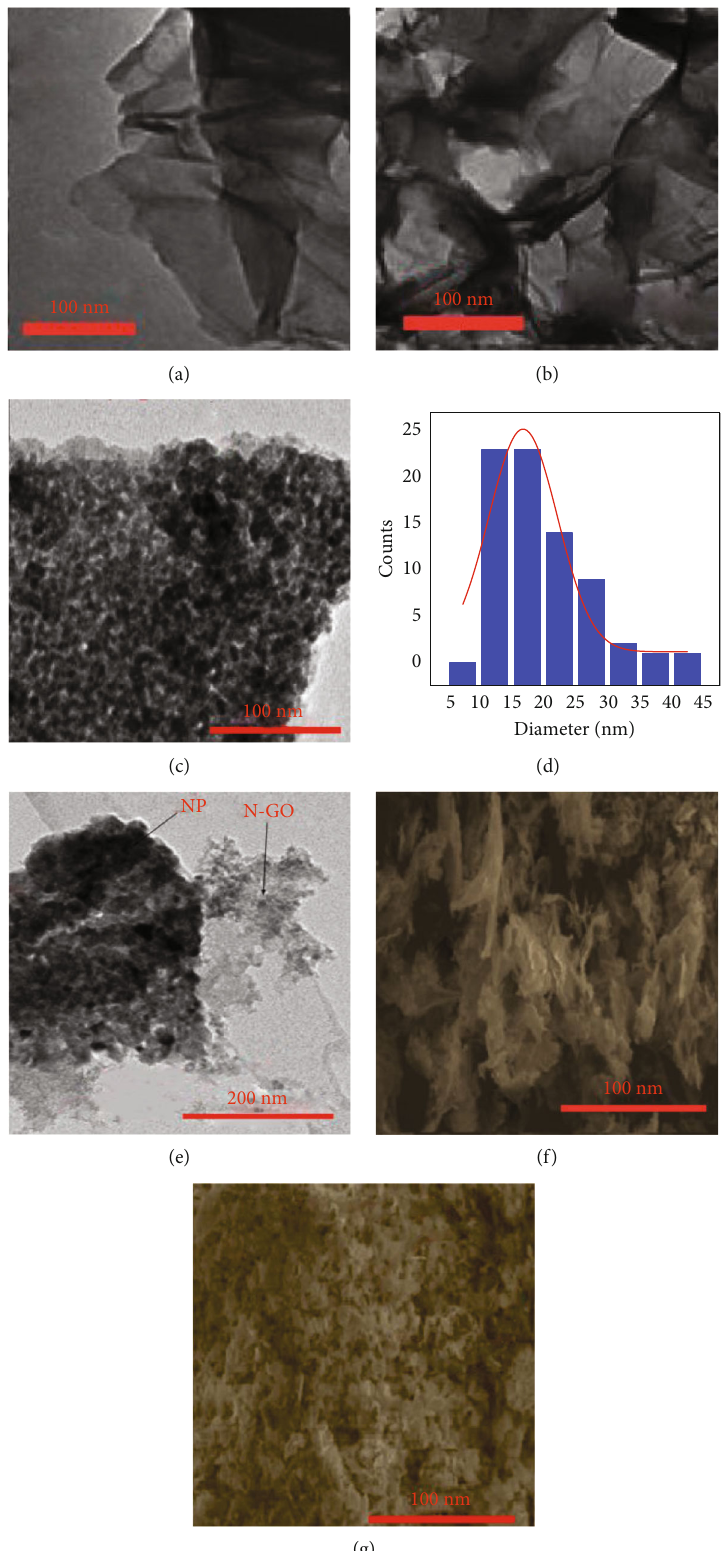
Figure 3: TEM images of GO (a), N-GO (b), CaFe nanocomposite (e), SEM images of